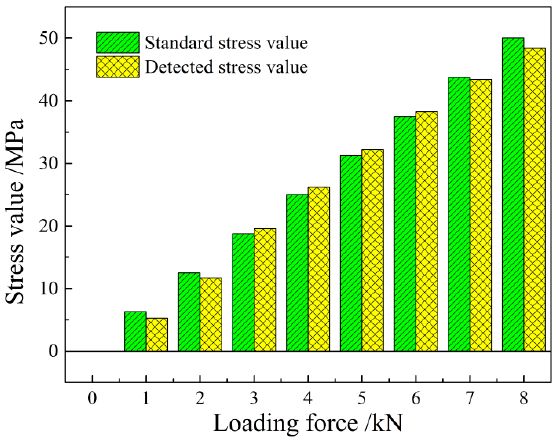
Figure 10. The comparison histogram of the standard and detected stress value.